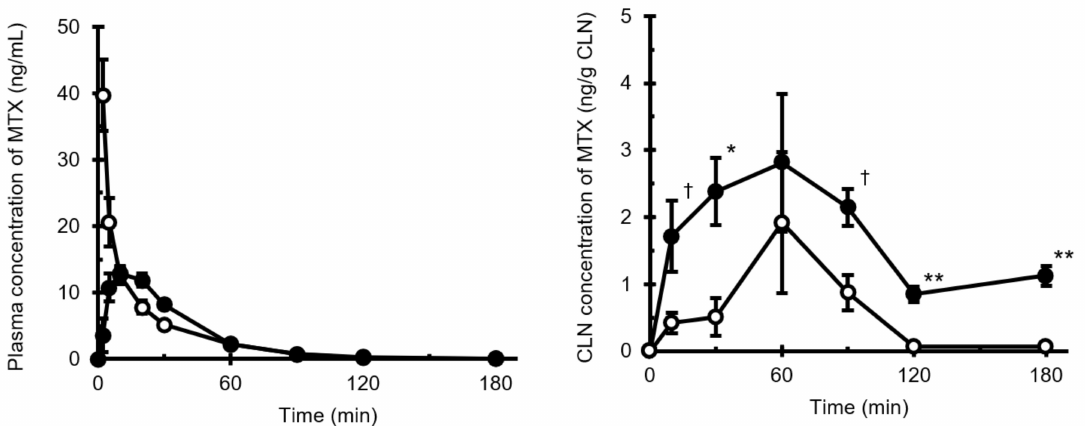
Figure 3. Plasma (left) and CLN (right) MTX concentration–time profiles following intranasal and intravenous administra- tion. Key: , i.v. administration; • , i.n. administration. Data points have been expressed as mean ± standard error for four (cid:35) (i.v.) and six (i.n.) experiments at each time point in the plasma concentration–time profile and for four (i.v.) and six (i.n.) experiments at each time point in the CLN concentration–time profile. † p < 0.10, * p < 0.05, ** p < 0.01. Abbreviations: CLN, cervical lymph node; MTX,